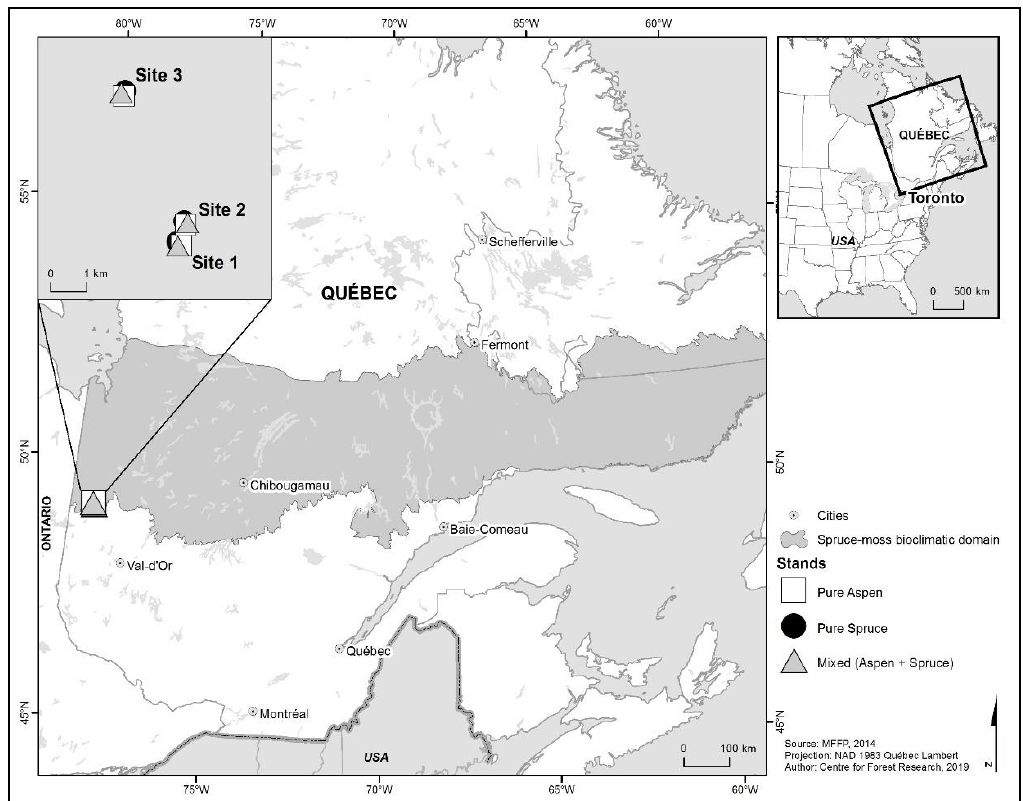
Figure 1. Location of the study sites in the spruce feathermoss bioclimatic domain of Quebec.